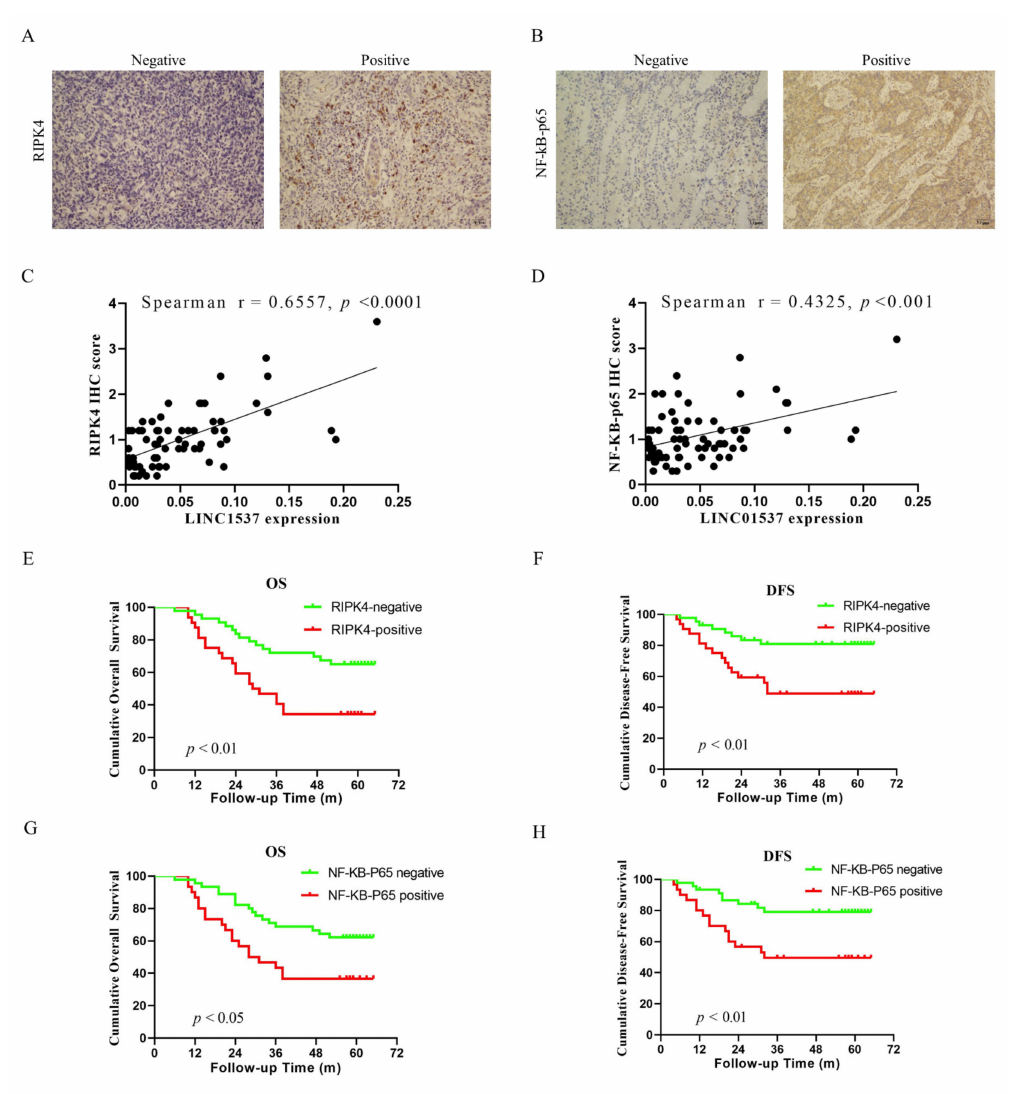
Figure 7. Clinical specimens prove that the high expressions of RIPK4 and NF- κ B -p65 in GC tissue were associated with poor prognoses. ( A , B ) The expression levels of RIPK4 and NF- κ B -p65 in IHC clinical specimens. ( C ) Correlation analysis of expression levels of LINC01537 and RIPK4 in clinical specimens. ( D ) Correlation analysis of expression levels of LINC01537 and NF- κ B -p65 in clinical specimens. OS ( E ) and DFS ( F ) were compared between RIPK4 high and low expressions in GC patients (RIPK4—negative, N = 43; RIPK4—positive, N = 32). OS ( G ) and DFS ( H ) were compared between NF- κ B -p65 high and low expressions in GC patients (NF- κ B—negative, N = 45; NF- κ B—positive, N = 30). Spearman correlation analysis was used to analyze correlations between LINC01537 expression and RIPK4 and NF- κ B -p65 IHC scores ( C , D ). The survival difference was determined using the Kaplan–Meier analysis and log-rank test ( E – H